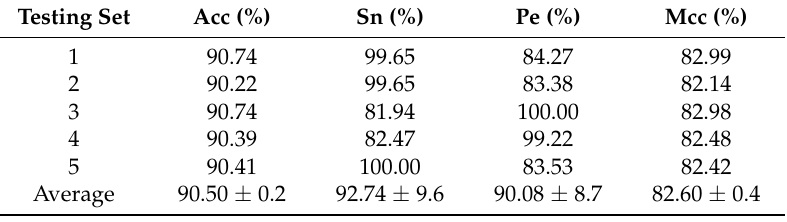
Table 4. Five-fold cross-validation results using the SVM-based method on the H. pylori dataset.